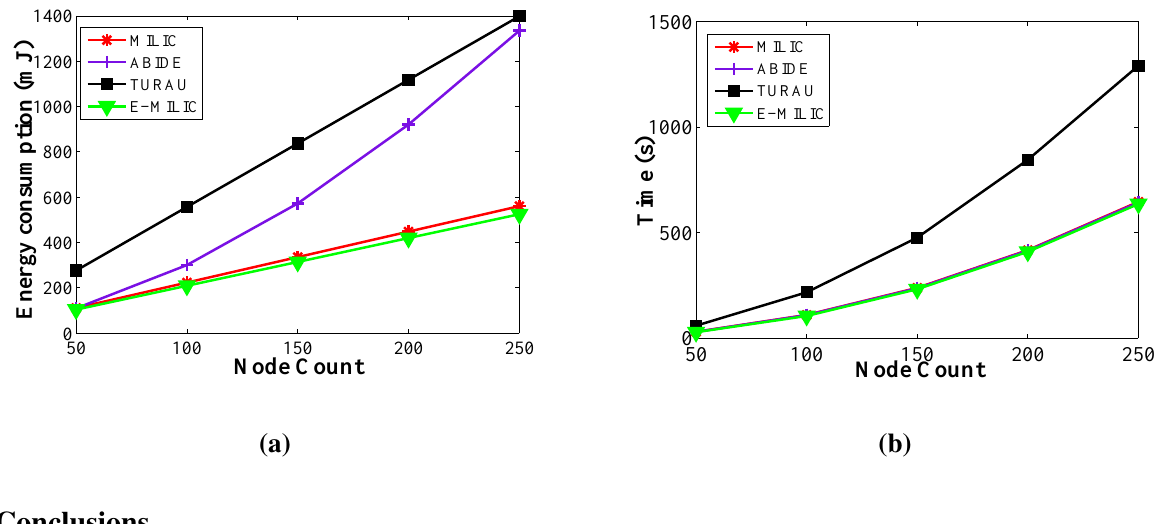
Figure 21. Comparisons between algorithms in terms of energy consumption and wall clock times for caterpillar-like graphs. ( a ) Energy consumption against node count; ( b ) wall clock times against node